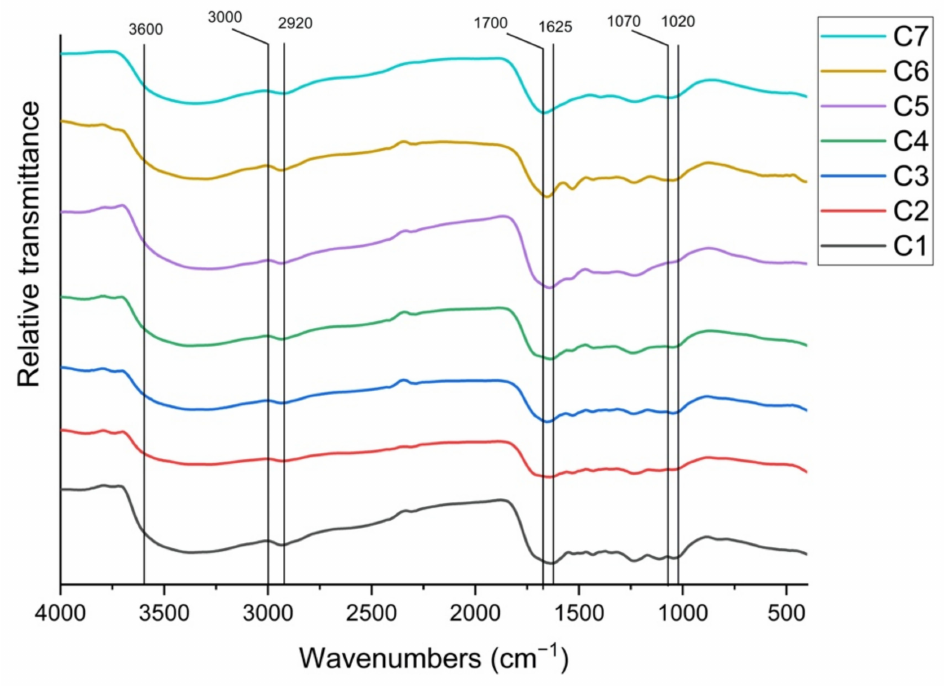
Figure 2. Fourier-transform infrared (FTIR) spectra of humic acids from compost samples. Compost labels according to the target waste: C1 fish waste; C2 horse manure; C3 sewage sludge; C4 green waste; C5 kitchen biowaste; C6 H. illucens frass; and C7